Question: Give a one-sentence summary of this figure.
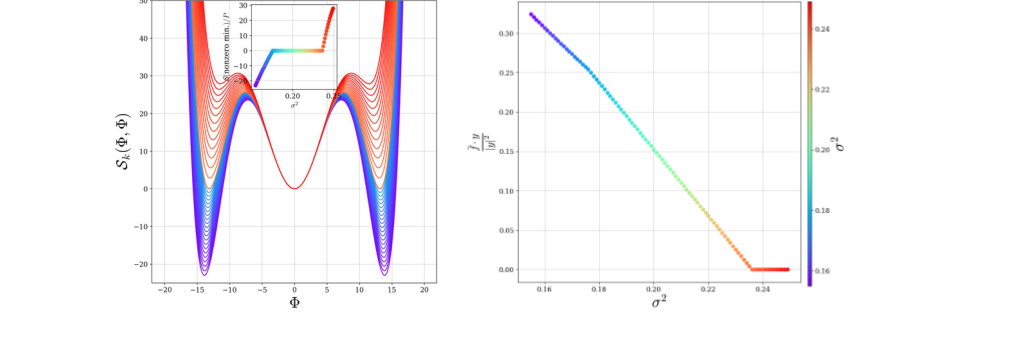
Answer: GFL to GMFL-I to GMFL-II (a) Probability distribution of weights as predicted by our approach. The GFL phase is represented by the red graphs, where the minimum of the action at zero (shared also by the GP limit) dominates the probability distribution. The GMFL-I phase can be seen in the inset graph, and the final GMFL-II phase is shown in purple.(b) The target component of the average network output. Here singularities can be observed at the σ2 values where the phase transi- tions occur. The Parameters taken in this calculation are: N = 1000, P = 401, σ2 a = 0.002/N, γ = 0.0001